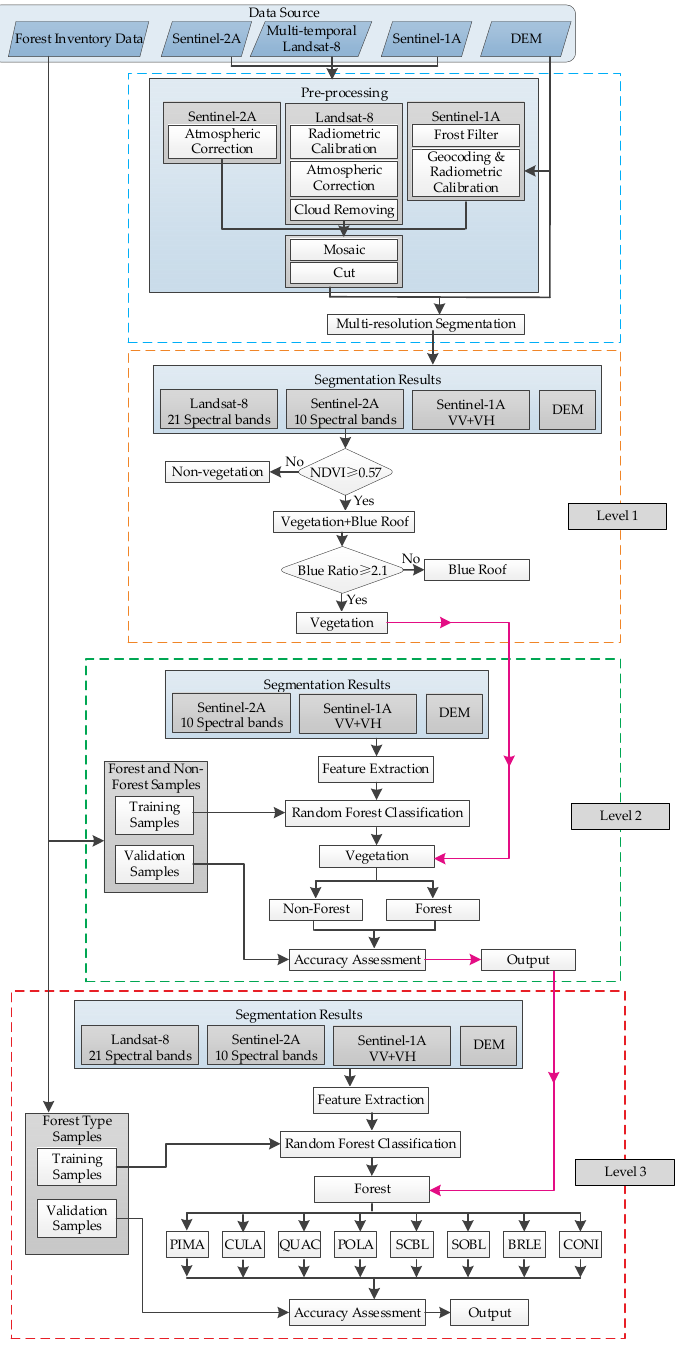
Figure 4. The pipeline of the proposed method.